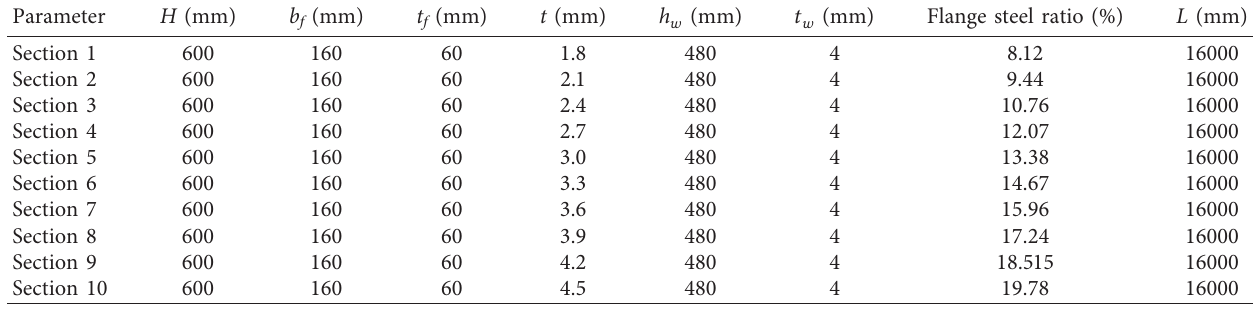
Table 10: The sizes of the sections.